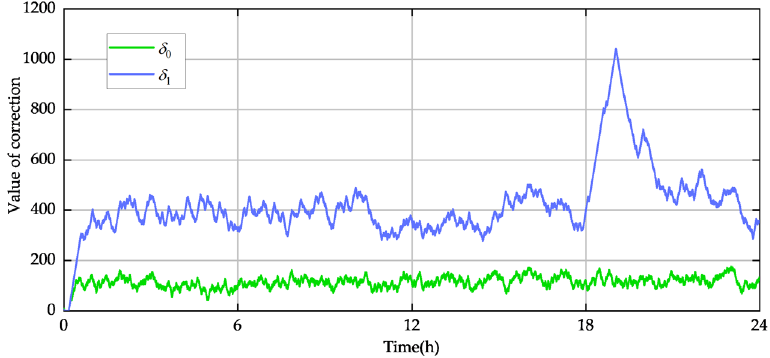
Figure 15. Adaptive variation of the correction quantity δ x